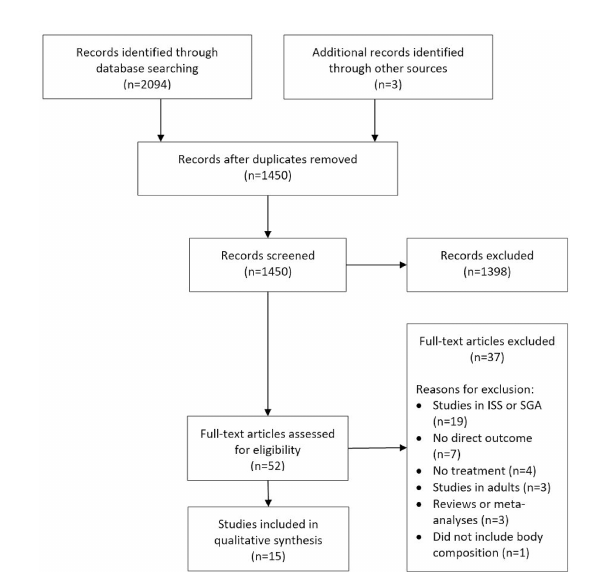
FIGURE 1 PRISMA fl ow diagram. This fi gure is an adaptation from “ Preferred Reporting Items for Systematic Reviews and Meta-Analyses: The PRISMA Statement. ” by Moher D, Liberati A, Tetzlaff J, Altman DG, The PRISMA Group (2009), and is used under a CC BY-NC-SA 4.0 license. ISS, idiopathic short stature; SGA, small for gestational